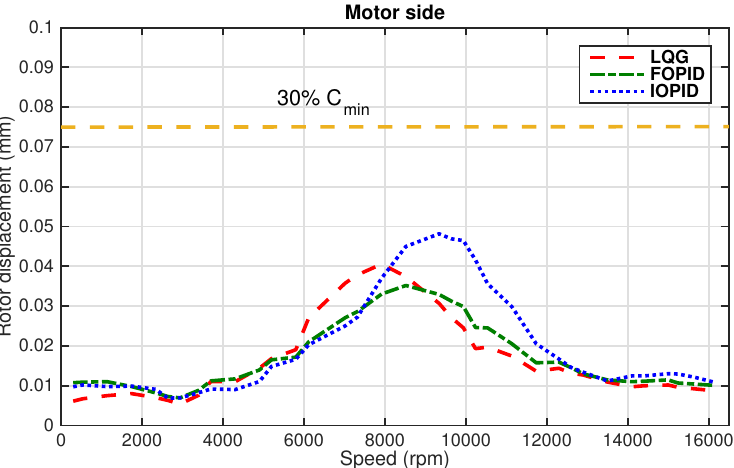
Figure 23. Rotor displacements at the motor side under the IOPID, FOPID, and LQG controllers.